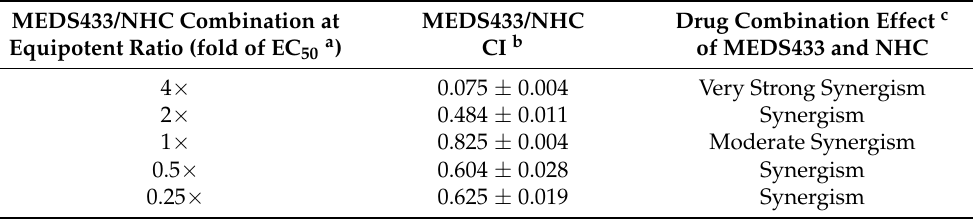
Table 3. Analysis of the effect of the combination of MEDS433 and NHC on IAV replication. MEDS433/NHC Combination at MEDS433/NHC Drug Combination Effect c Equipotent Ratio (fold of EC 50 a ) CI b of MEDS433 and NHC 4 × 0.075 ± 0.004 Very Strong Synergism 2 × 0.484 ± 0.011 Synergism 1 × 0.825 ± 0.004 Moderate Synergism 0.5 × 0.604 ± 0.028 Synergism 0.25 × 0.625 ± 0.019